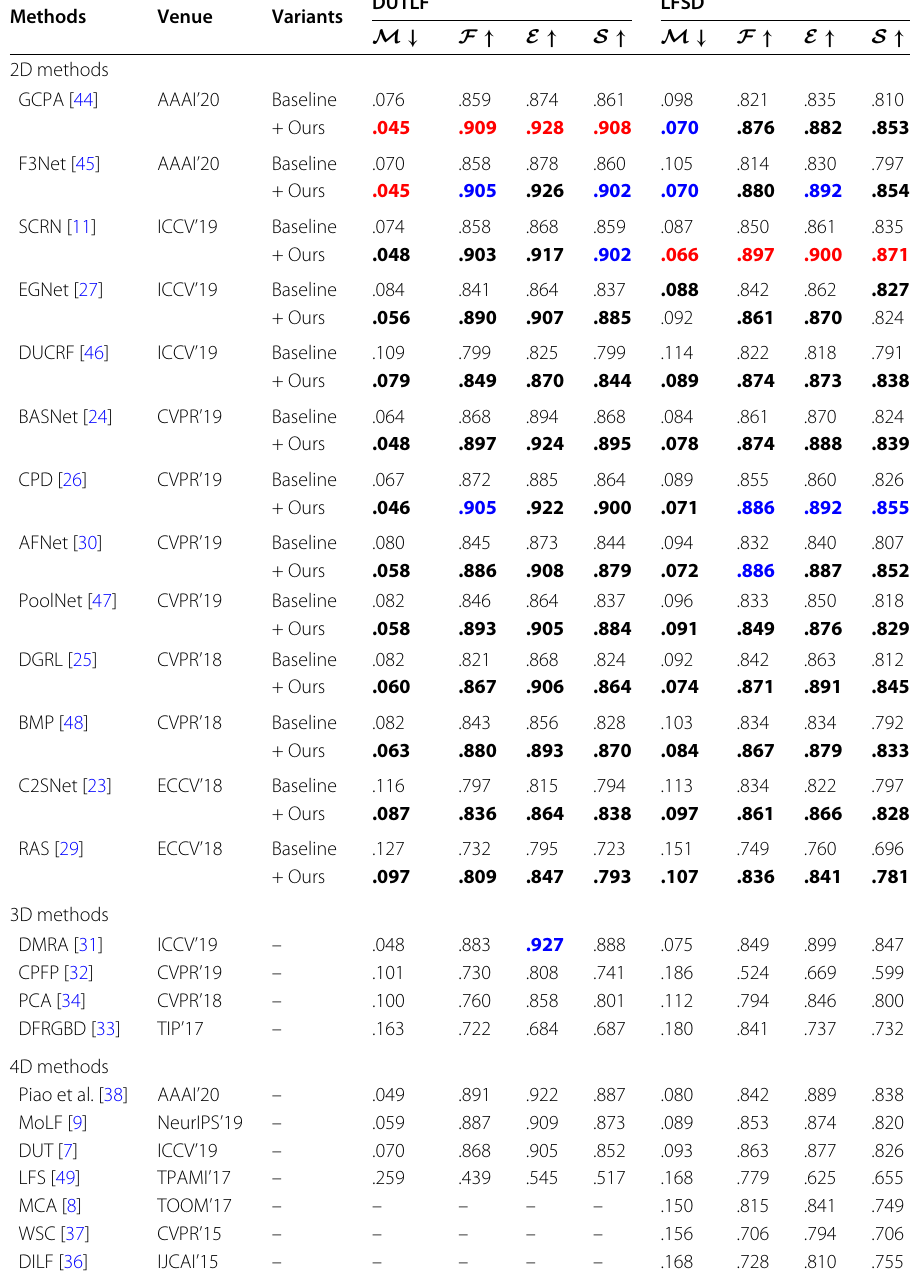
Table 1 Quantitative comparisons of mean absolute error ( M ), F -measure ( F ), E -measure ( E ), and S -measure ( S ) on two light field datasets, i.e., DUTLF [7] and LFSD [6]. Baseline denotes the results of 2D methods over all-focus images, while +Ours denotes the results after the selection of our proposed method. Red and blue denote the best and second scores, respectively. The up arrow ↑ means larger is better while the down arrow ↓ means smaller is